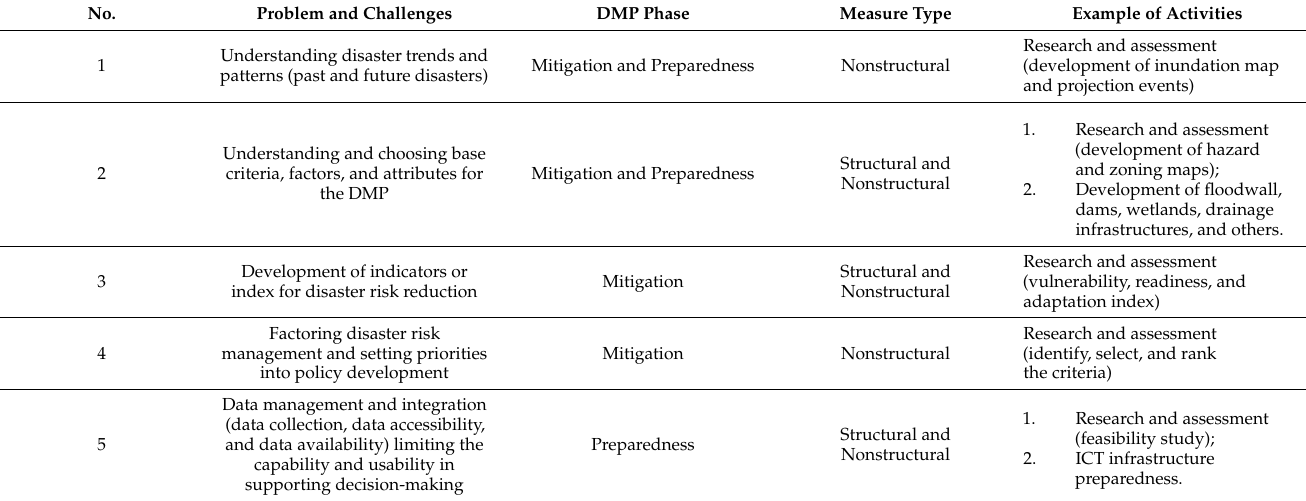
Table 2. Problems and challenges in decision-making for managing